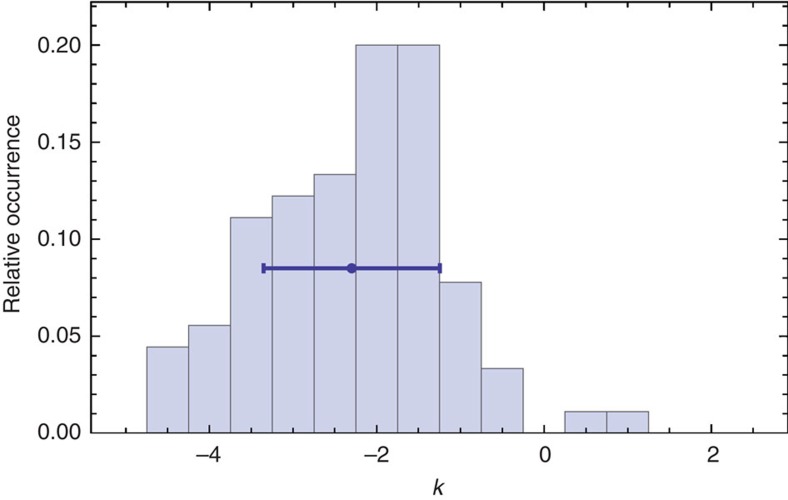
Estimated coefficients.Depicted is the histogram of best estimated coefficients k in the local approximation within [ωmin, ωmax] of the spectral density by I(ω)=Cωk, showing a statistically significant deviation from the Ohmic situation of k=1.